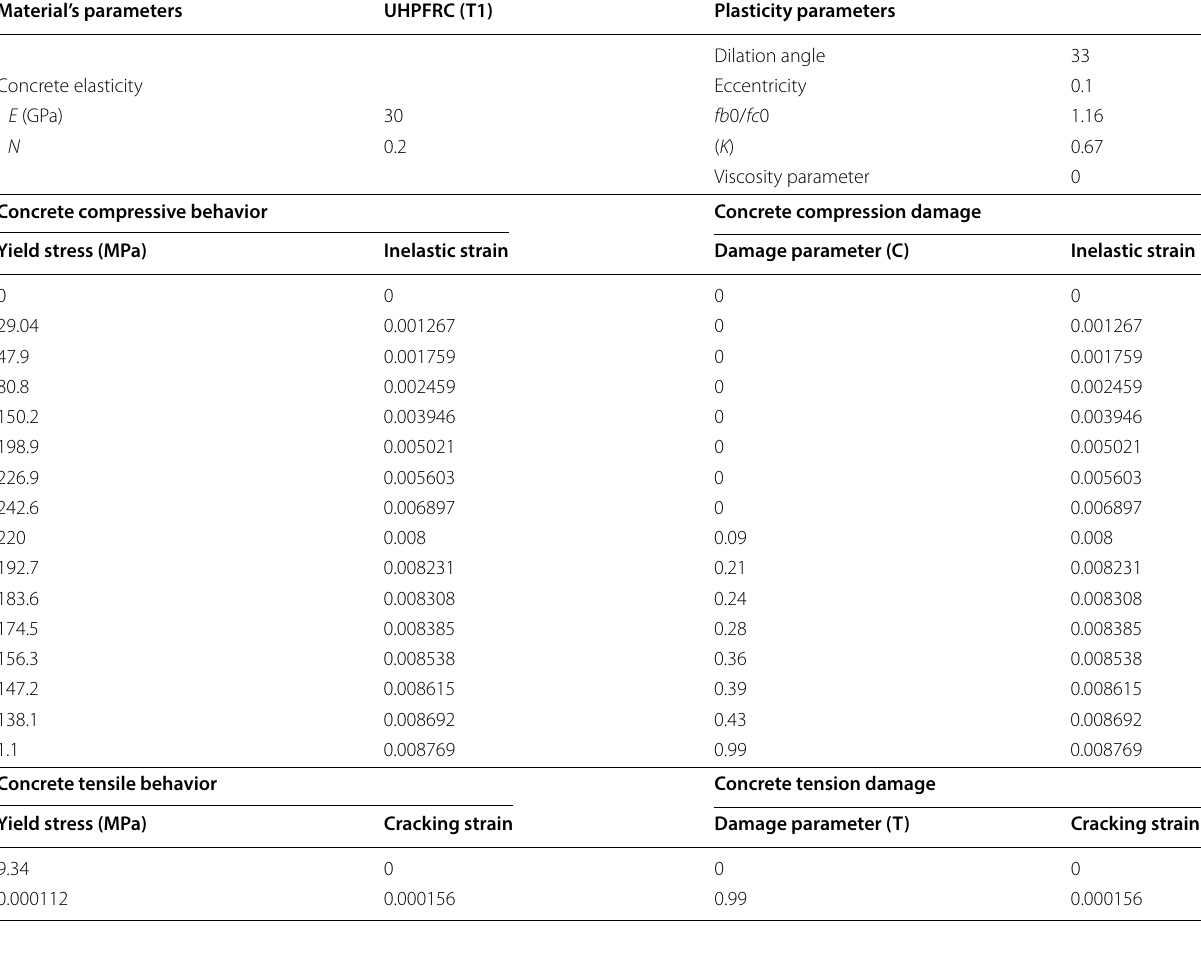
Table 4 Material properties for concrete with developed constitutive model in UHPFRC with micro and hooked ends (T1)